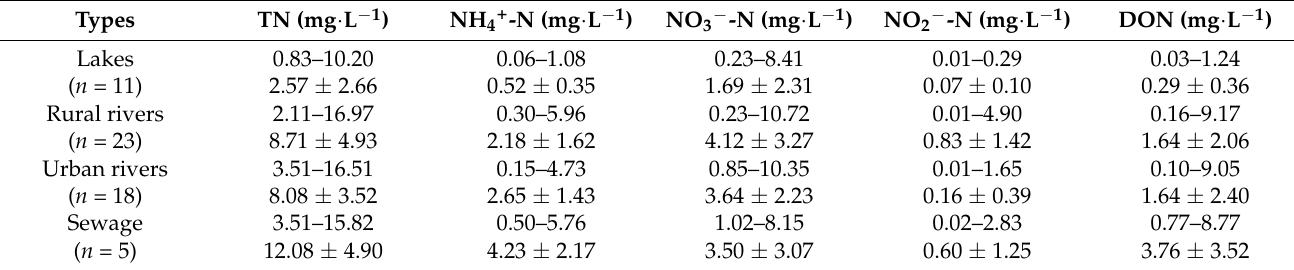
Figure 3. Concentrations of nitrogen species in river waters in Tianjin. Table 2. Statistics of the nitrogen species in surface water in Tianjin,